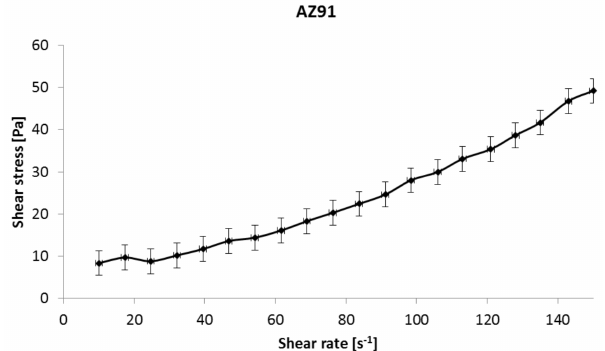
Figure 2. Flow curve of alloy AZ91, at a solid phase share of 50%.